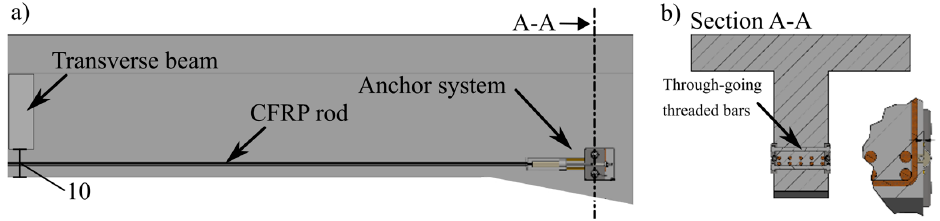
Figure 5. Side view ( a ) and section view ( b ) of the planned strengthening method (measures in cm).